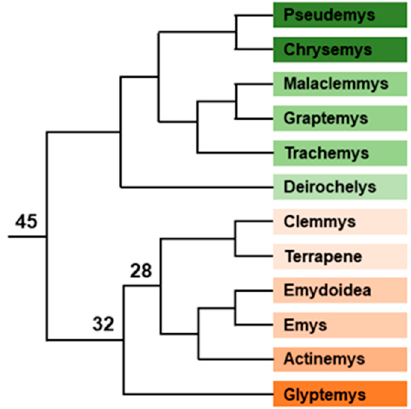
Figure 7. Phylogenic tree of emydid turtles. Relative position of each genus and superior clade are represented. Branch lengths are not proportional to time. Numbers indicate divergence time (Myrs) from present for some key nodes, according to [39]. Color of each genus indicates the different clades.